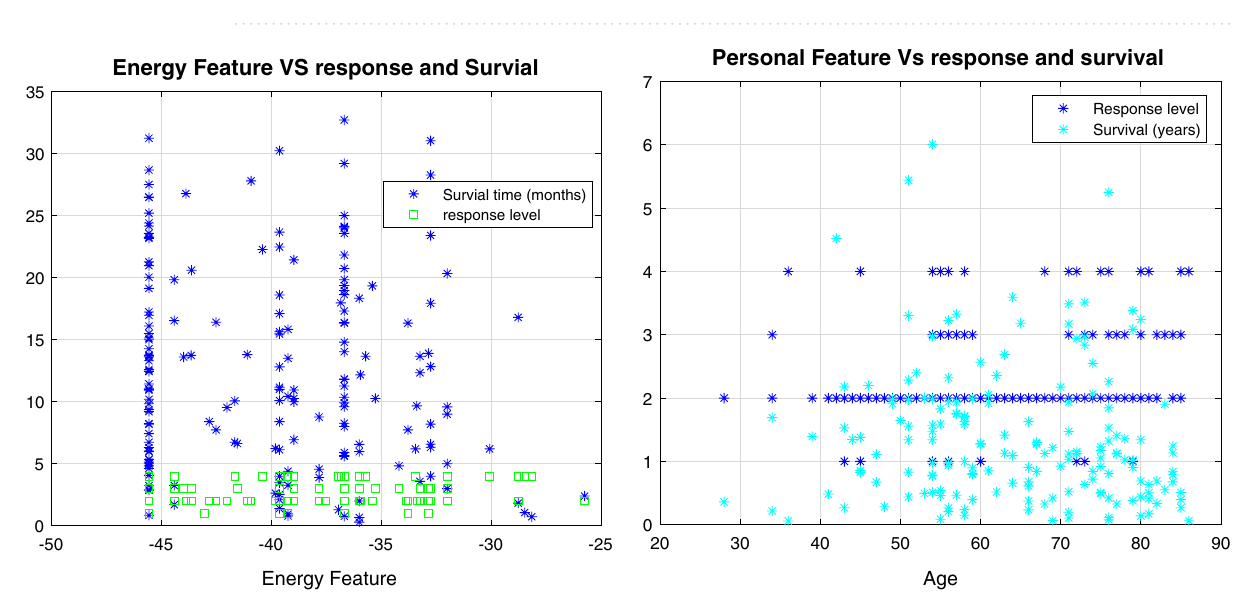
Figure 4. Disease response classification and survival time (months) by binding free energy (left panel) and disease response classification and survival time (years) by age of patient (right